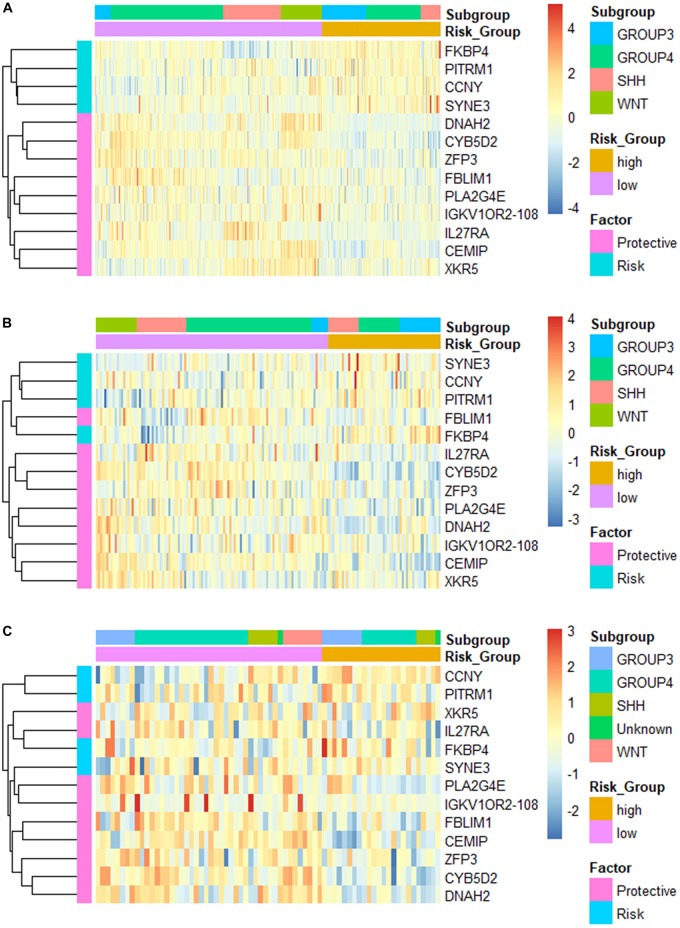
Heatmap of the constructed 13-gene signature for (A) training set; (B) validation set 1; and (C) validation set 2, clustered by gene expression level and risk groups.